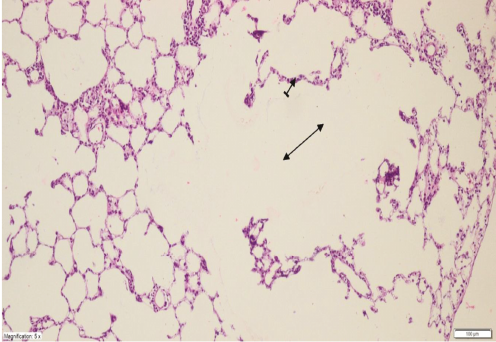
Figure 5: Extensive alveolar oedema (double-sided arrow) and severe alveolar damage (dashed arrow) in the lung tissue of the CIS group (H&E × 100).